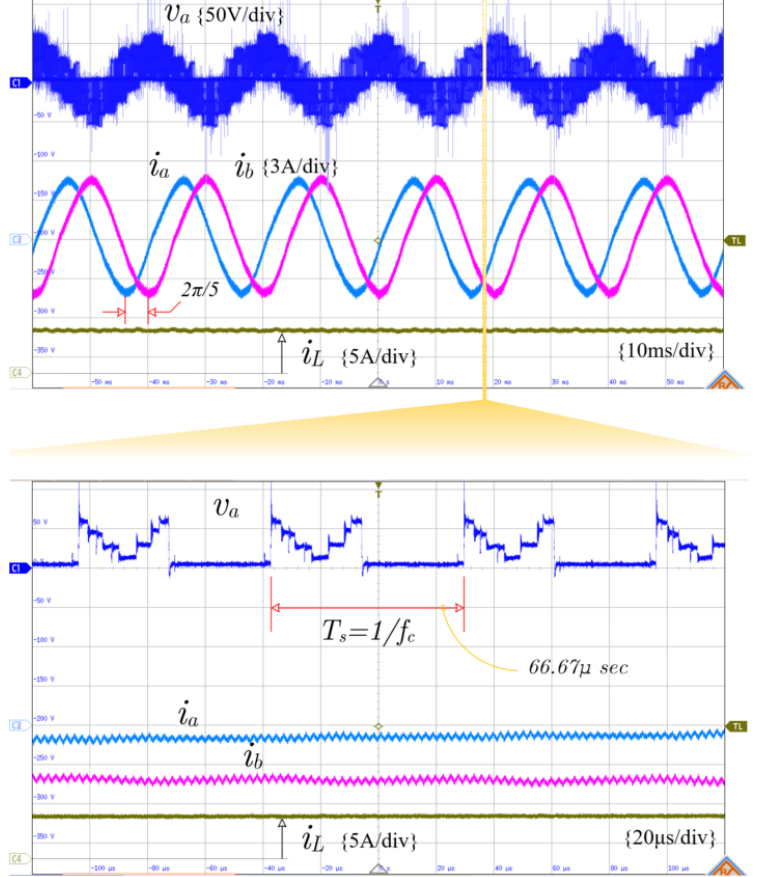
Figure 21. Experimental waveforms of output-phase voltage, two adjacent phase currents, and the supply or inductor current for the proposed five-phase SSI with the modified space-vector modulation scheme.